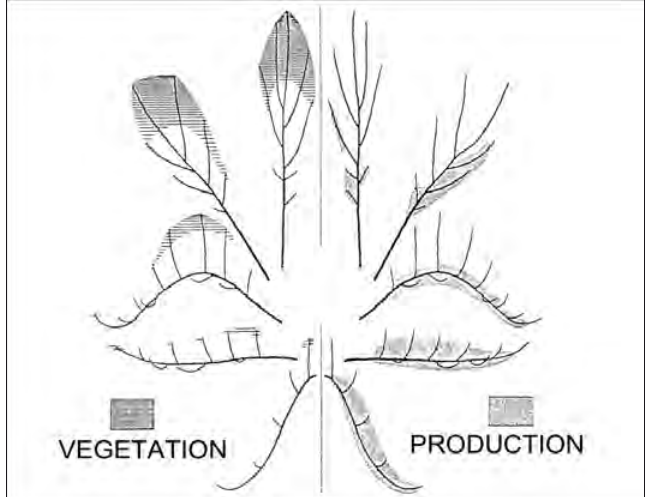
Fig. 7 - The relative location of vegetative and reproductive activities may be changed by variations of growth direction of axes im- posed by pruning.